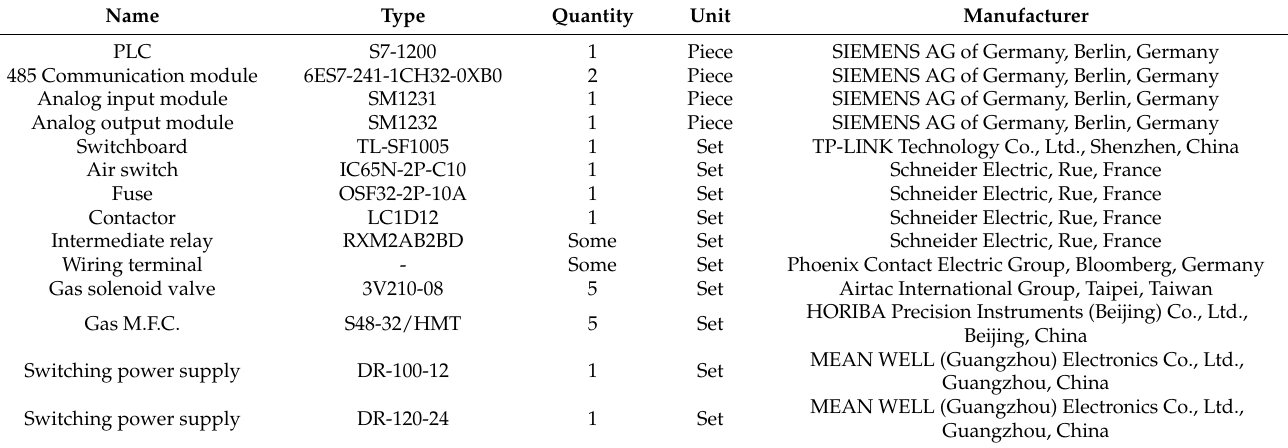
Figure 2. Block diagram of PLC control system. Table 1. A detailed list of the internal control components in the electronic control